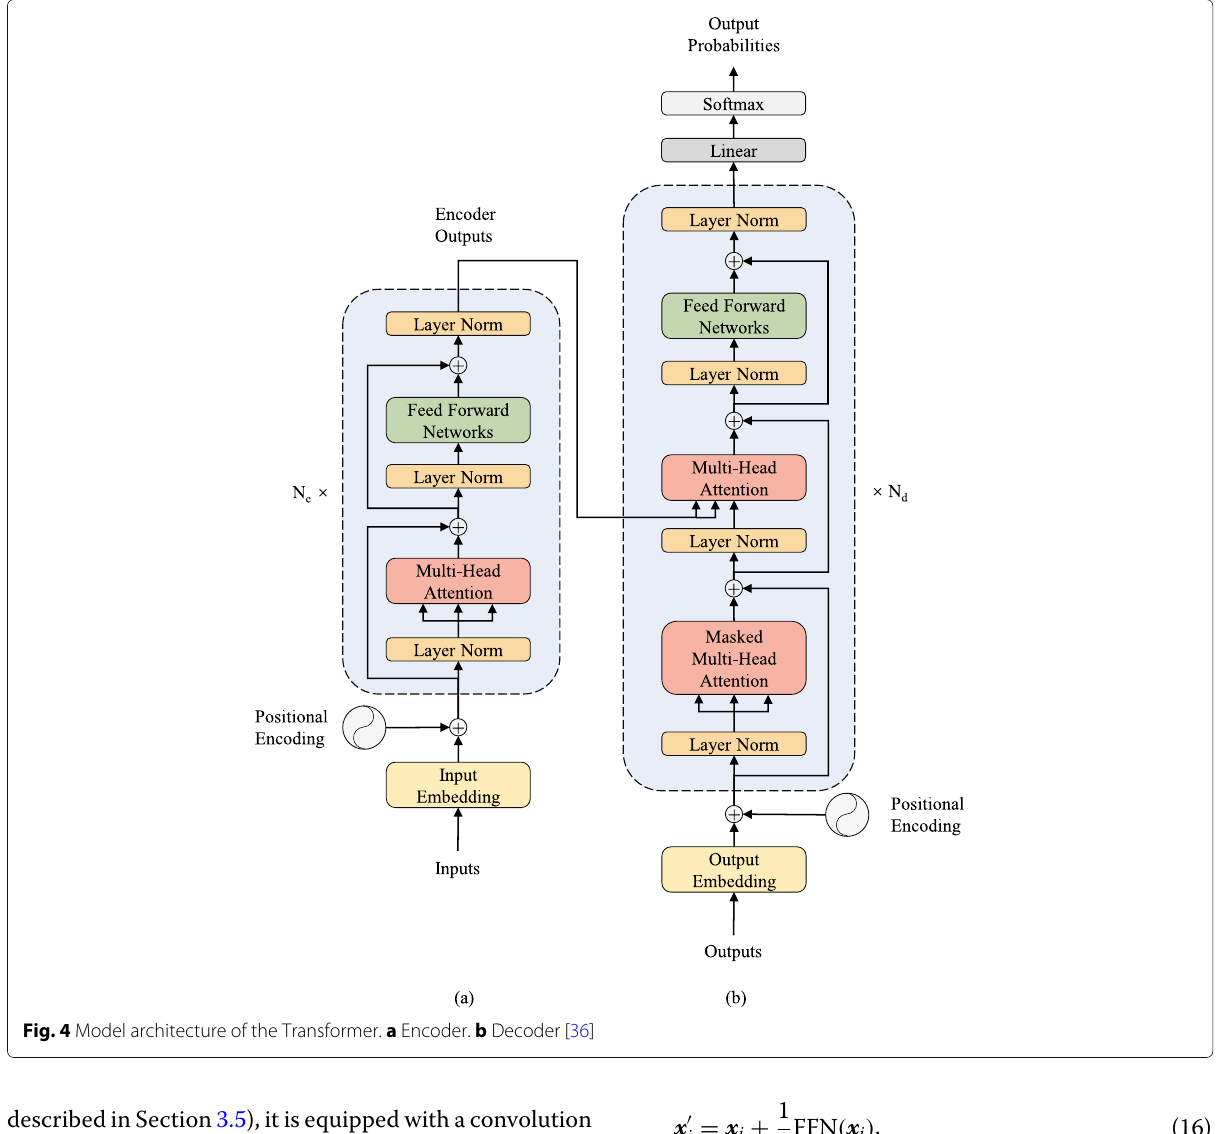
layer to increase the local information modeling capabil- ity of the Transformer encoder model [49] and a pair of FFN modules sandwiching the multi-head self-attention former model consists of a Conformer encoder proposed